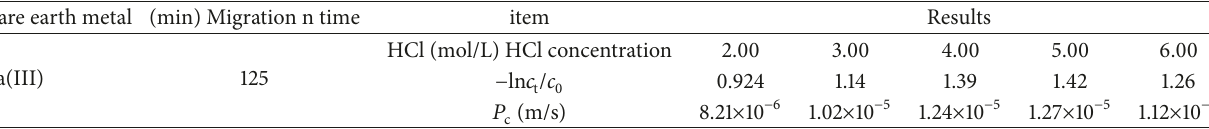
Table 2: Effect of HCl concentration in the dispersion phase on transport of rare earths.